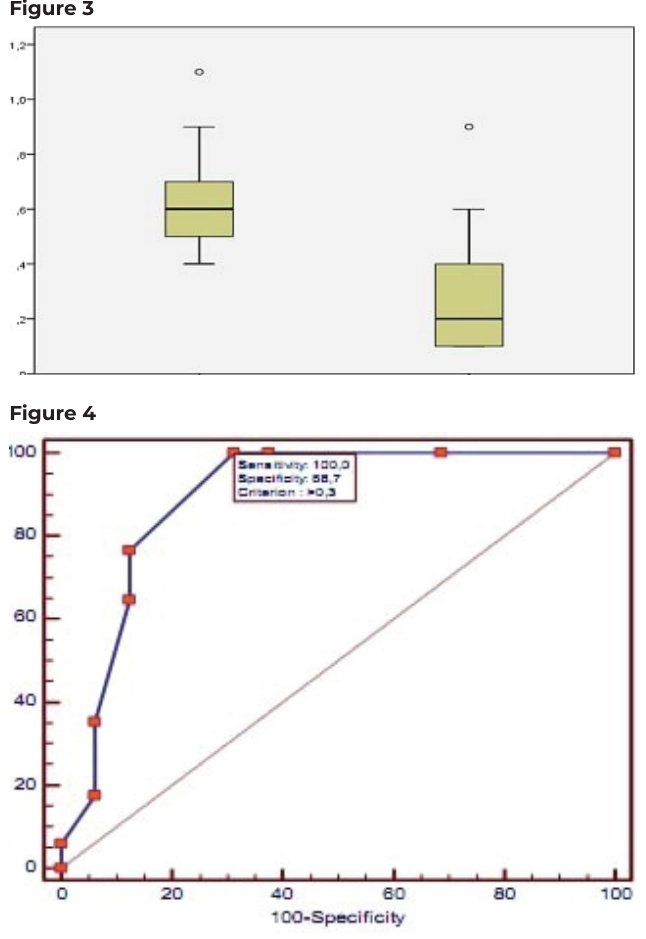
Elastographic pattern of AML in right kidney was 2 and strain index ratio was measured 0.2 (Figure